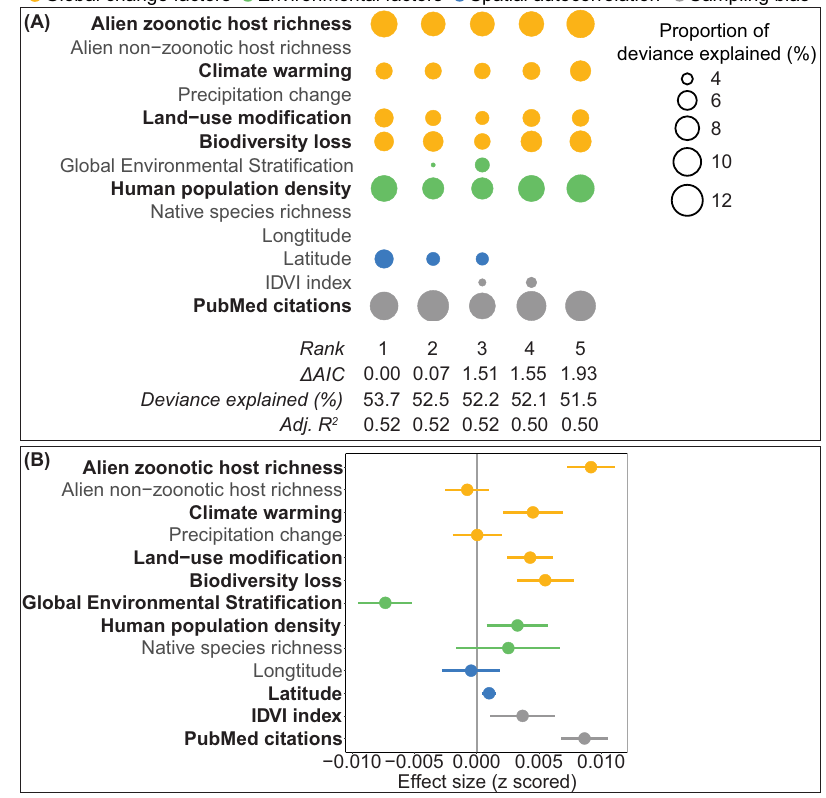
Fig. 3 Proportion of deviance explained and effect size of each predictor variable in model averaging analyses based on GAMMs. Columns represent individual models and rows represent predictor variables, with smoothing function knot value = 10. Shown in bold are the variables that appear in all fi ve of the most highly supported models in panel A and that have model-averaged 95% con fi dence intervals that do not overlap zero in panel B . The circle size in panel A represents the proportion of deviance explained by each predictor and any blanks indicate that the predictor is not included in the model. The panel B represents mean effect sizes with 95% con fi dence intervals of different predictor variables explaining the number of zoonosis events worldwide ( n = 10,473, Supplementary Data 4).